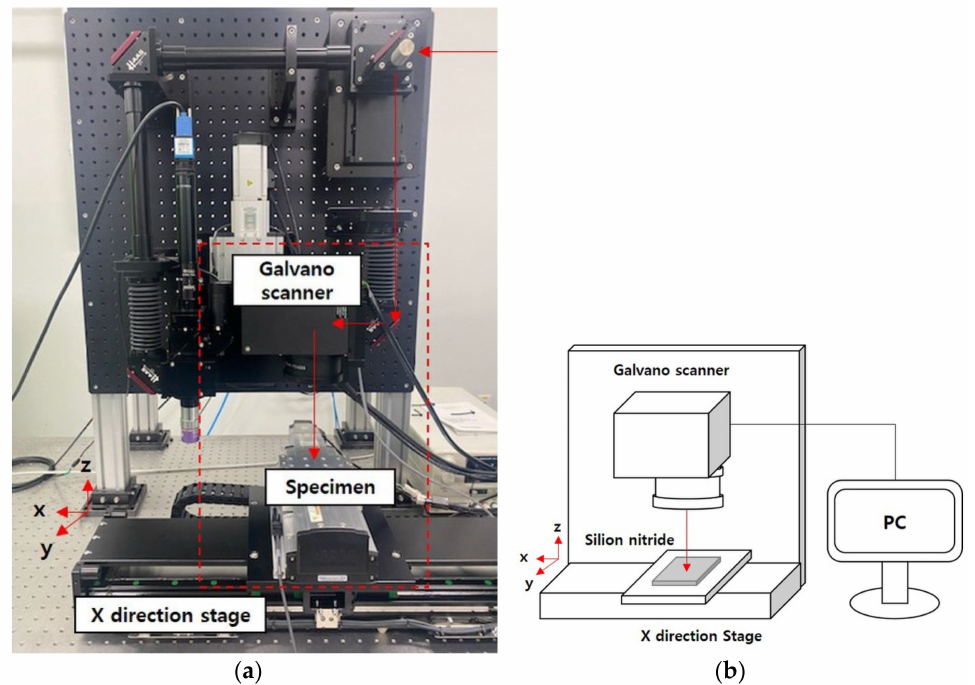
Figure 1. Equipment configuration for laser processing: ( a ) actual equipment for laser processing; ( b ) schematic of laser